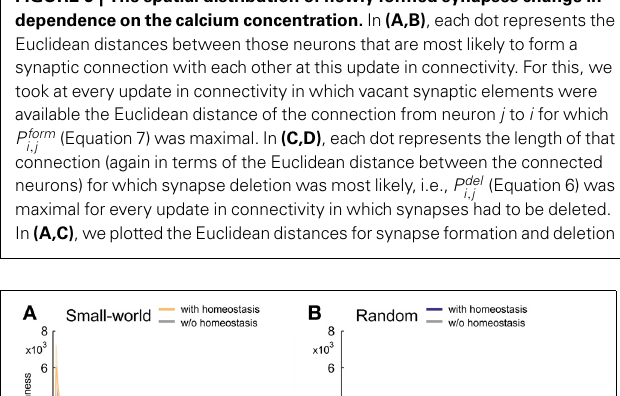
FIGURE 10 | Changingbetweennesscentralityovertime.(A) Small-world networks with (orange) and without (gray) homeostasis in electrical activity. (B) Randomnetworkswith(blue)andwithout(gray)homeostasisinelectrical activity. Means over five simulations per scenario. Shadings of the curves indicate standard